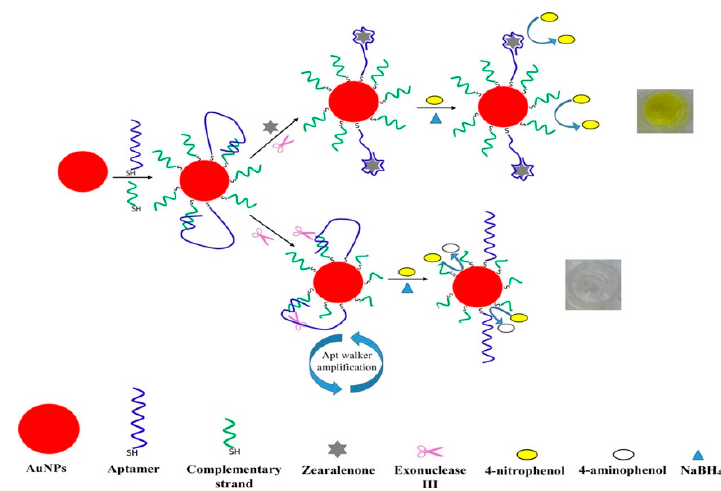
Figure 14. The representation of the detection of zearalenone based on the exonuclease III-aided aptamer walker and catalytic reaction of AuNPs. Reproduced with permission from Reference [147]. American Chemical Society, 2018.